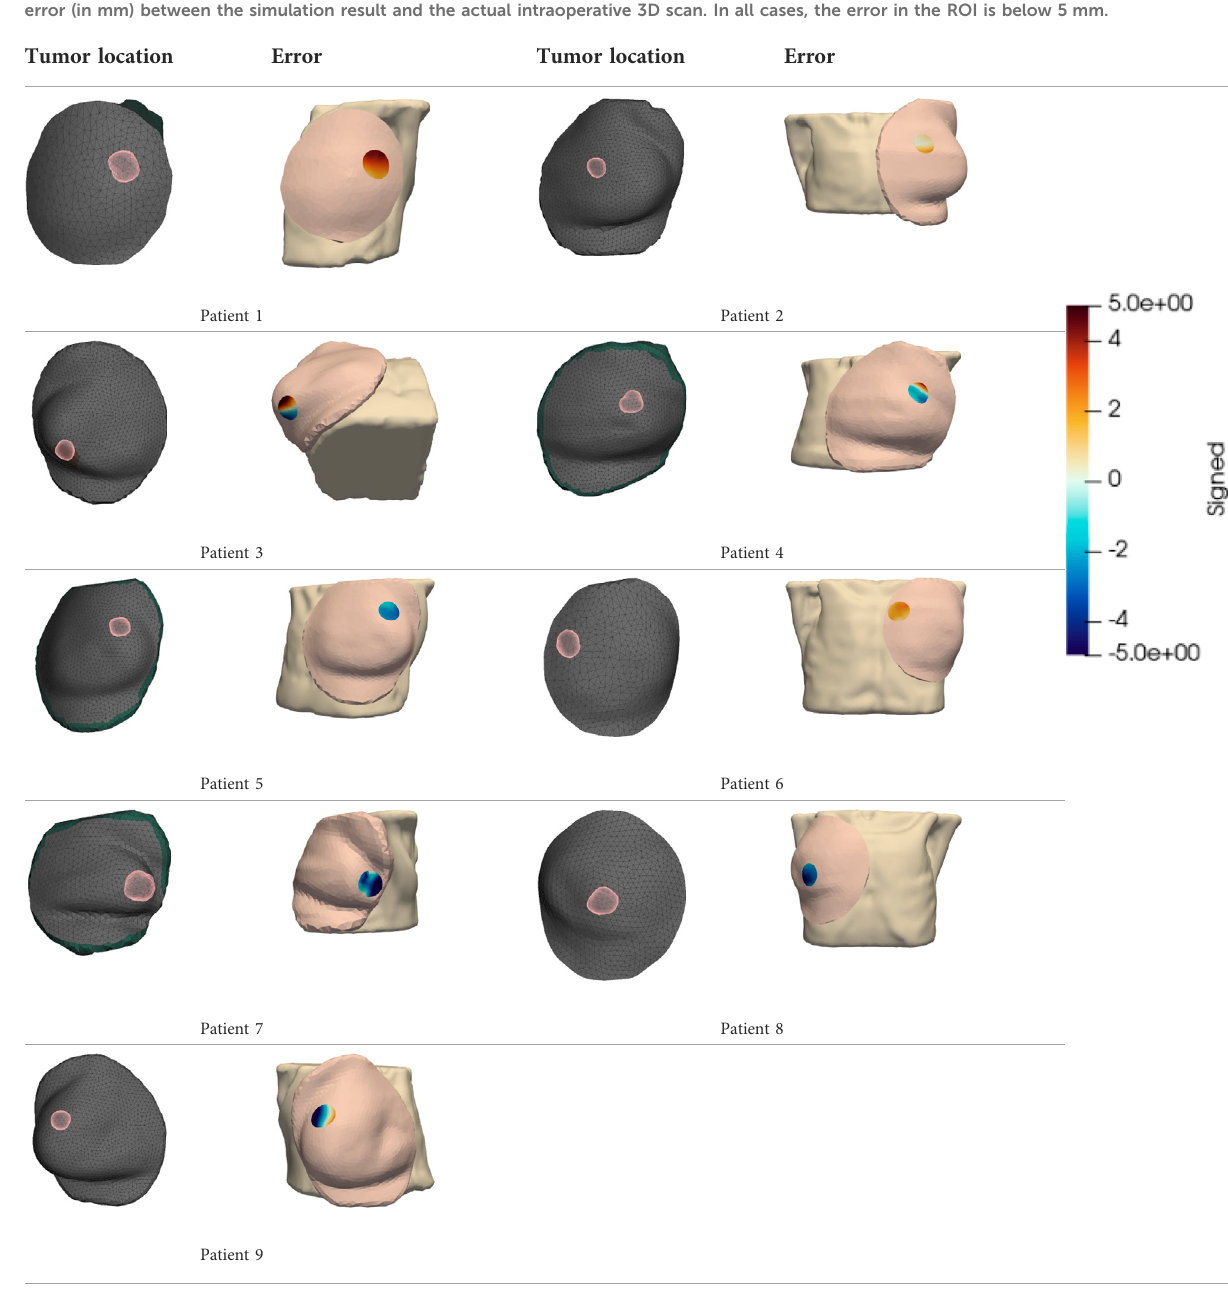
TABLE 2 Quantitative evaluation of the deformation error between preoperative and intraoperative setting. We initialize the simulation mesh in preoperative supine position, we apply the orientation corresponding to the intraoperative con fi guration to each patient (see Table 1), and we compute the deformation of the breast tissue. With this deformation, we transform the preoperative 3D surface scan, we register the result to the intraoperative 3D surface scan, and we measure the error on the region-of-interest (ROI) closest to the tumor. The colors indicate signed-distance error (in mm) between the simulation result and the actual intraoperative 3D scan. In all cases, the error in the ROI is below 5